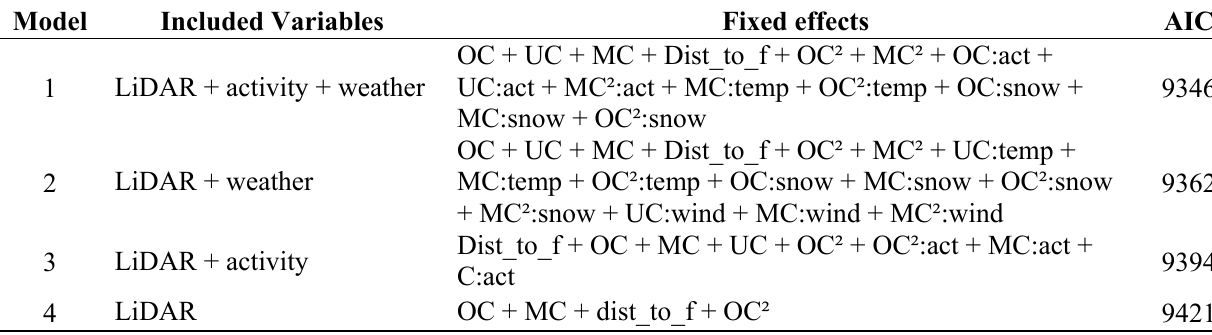
Table 1. Summary of calculated mixed conditional logistic regression models explaining habitat selection and associated Akaike’s Information Criterion(AIC) values; model 1 incorporates weather variables and activity status, model 2 only weather variables, model 3 only activity status, and model 4 neither of the two; all models incorporated individuals